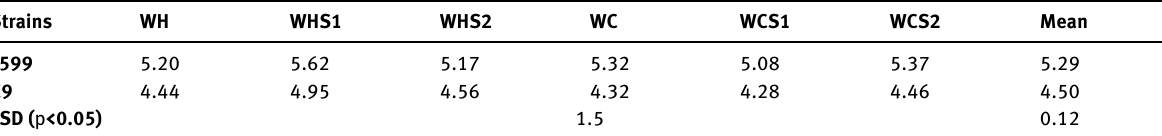
Table 2: Diameter of pileus of A. bisporus on various composts